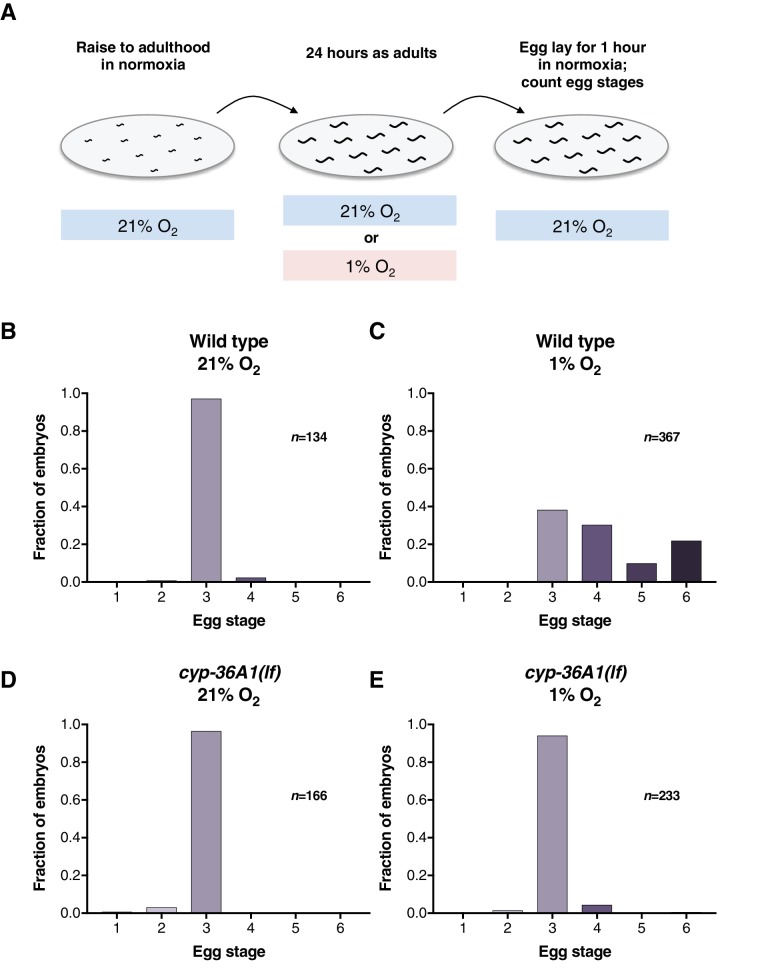
cyp-36A1(lf) suppresses the egg-laying defect of hypoxia-exposed animals.(A) Schematic depicting experimental design. (B–E) Distribution of stages of eggs laid by adult hermaphrodites. (B) Stages of eggs laid by wild-type animals grown in normoxia (21% O2). (C) Animals exposed to hypoxia (1% O2) for 24 hr as adults laid later stage eggs than those in normoxia (p<0.001, Chi-square test with Holm-Bonferroni correction). (D) cyp-36A1(gk824636) mutants grown in normoxia displayed wild-type egg laying (p>0.05). (E) cyp-36A1(gk824636) mutants exposed to 1% O2 laid eggs at earlier stages than wild-type animals in the same condition (p<0.001).